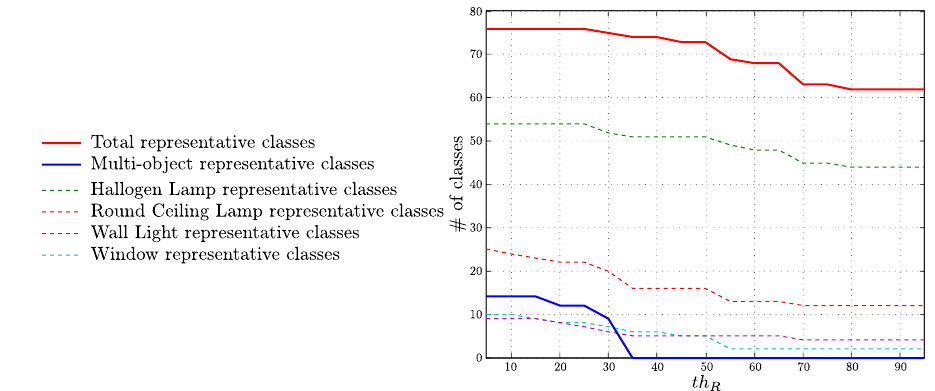
Figure 8. Representative classes for each object and representative classes associated to more than one object (multi-object classes) for different values of th R . In the analyzed vocabulary, 342 classes were